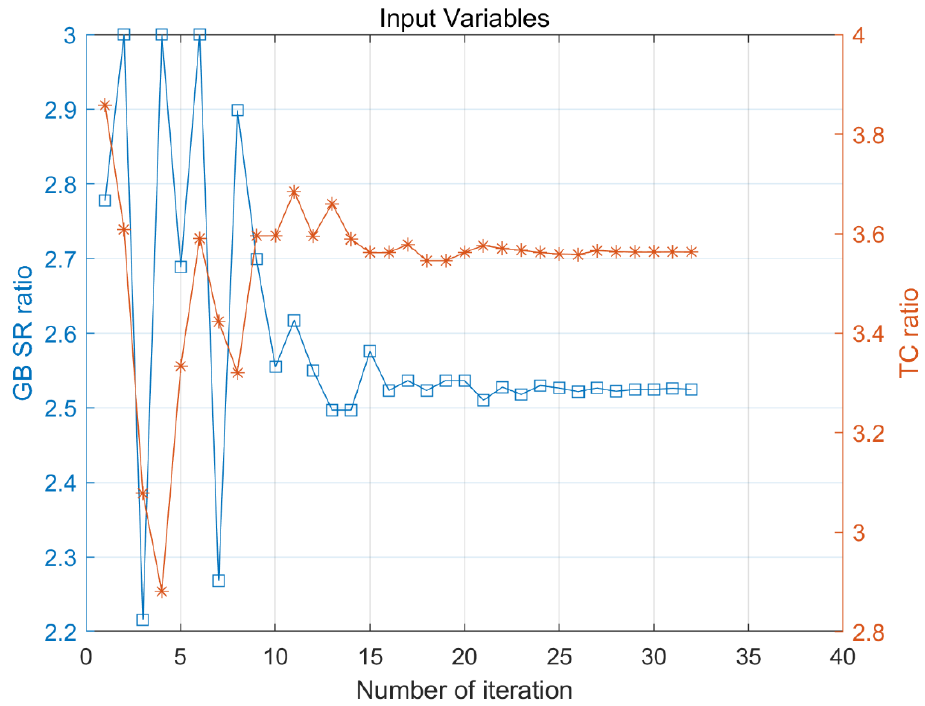
Figure 6. Optimization results for the TC(orange, asterisk) and GB(blue, cube) ratios. Table 3. Component-sizing results and acceleration performance for Case 1.